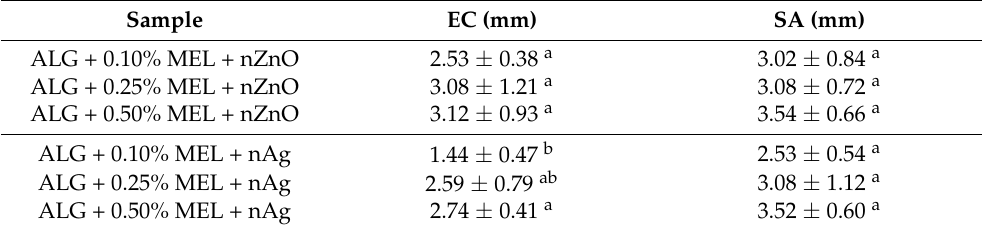
Table 6. Summary of the size of the zones of growth inhibition (expressed in mm) for E. coli (EC) and S. aureus (SA) around discs made of films modified with AgNP and